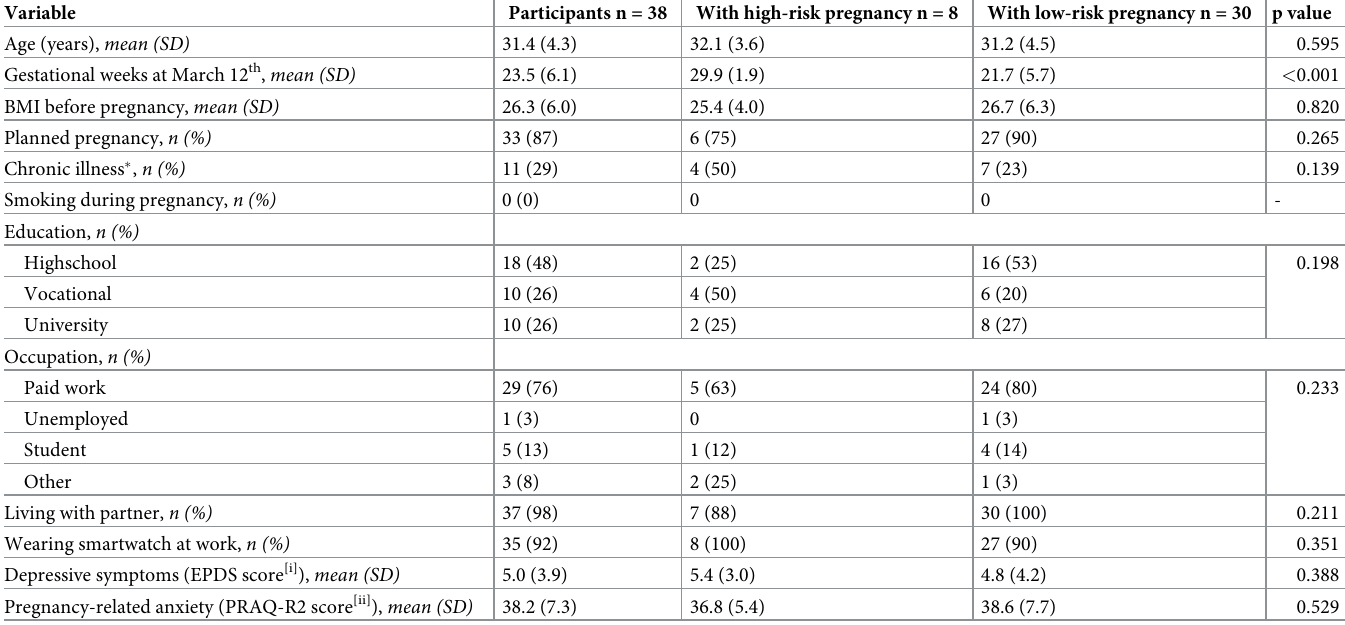
Table 1. The characteristics of the participating pregnant women.